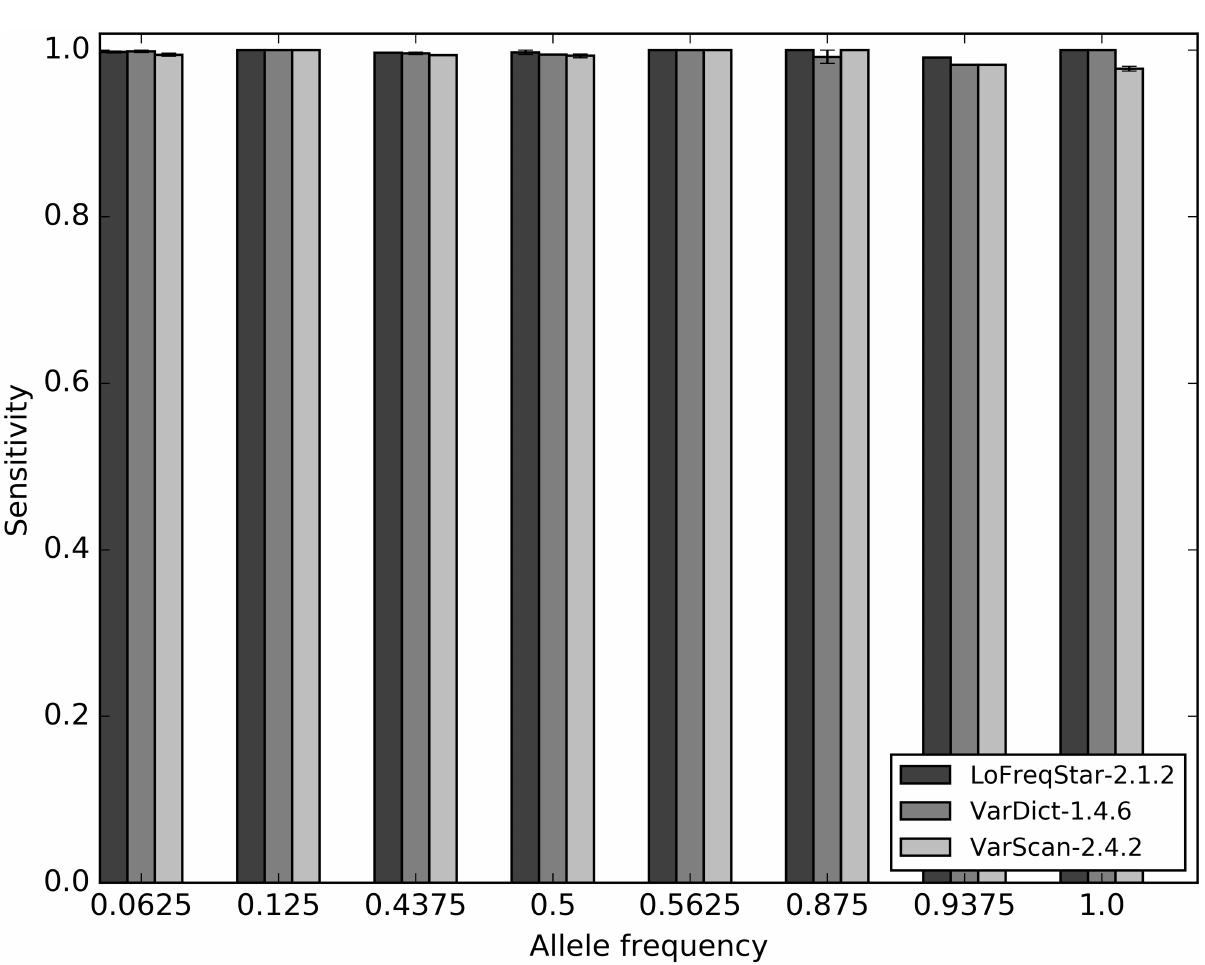
Fig 6. Sensitivity of LoFreqStar, VarDict and VarScan on the GiaB reference samples averagedover the four replicates. Becauseof the 1:7 mixtures, allelefrequencies are discrete for the given values.